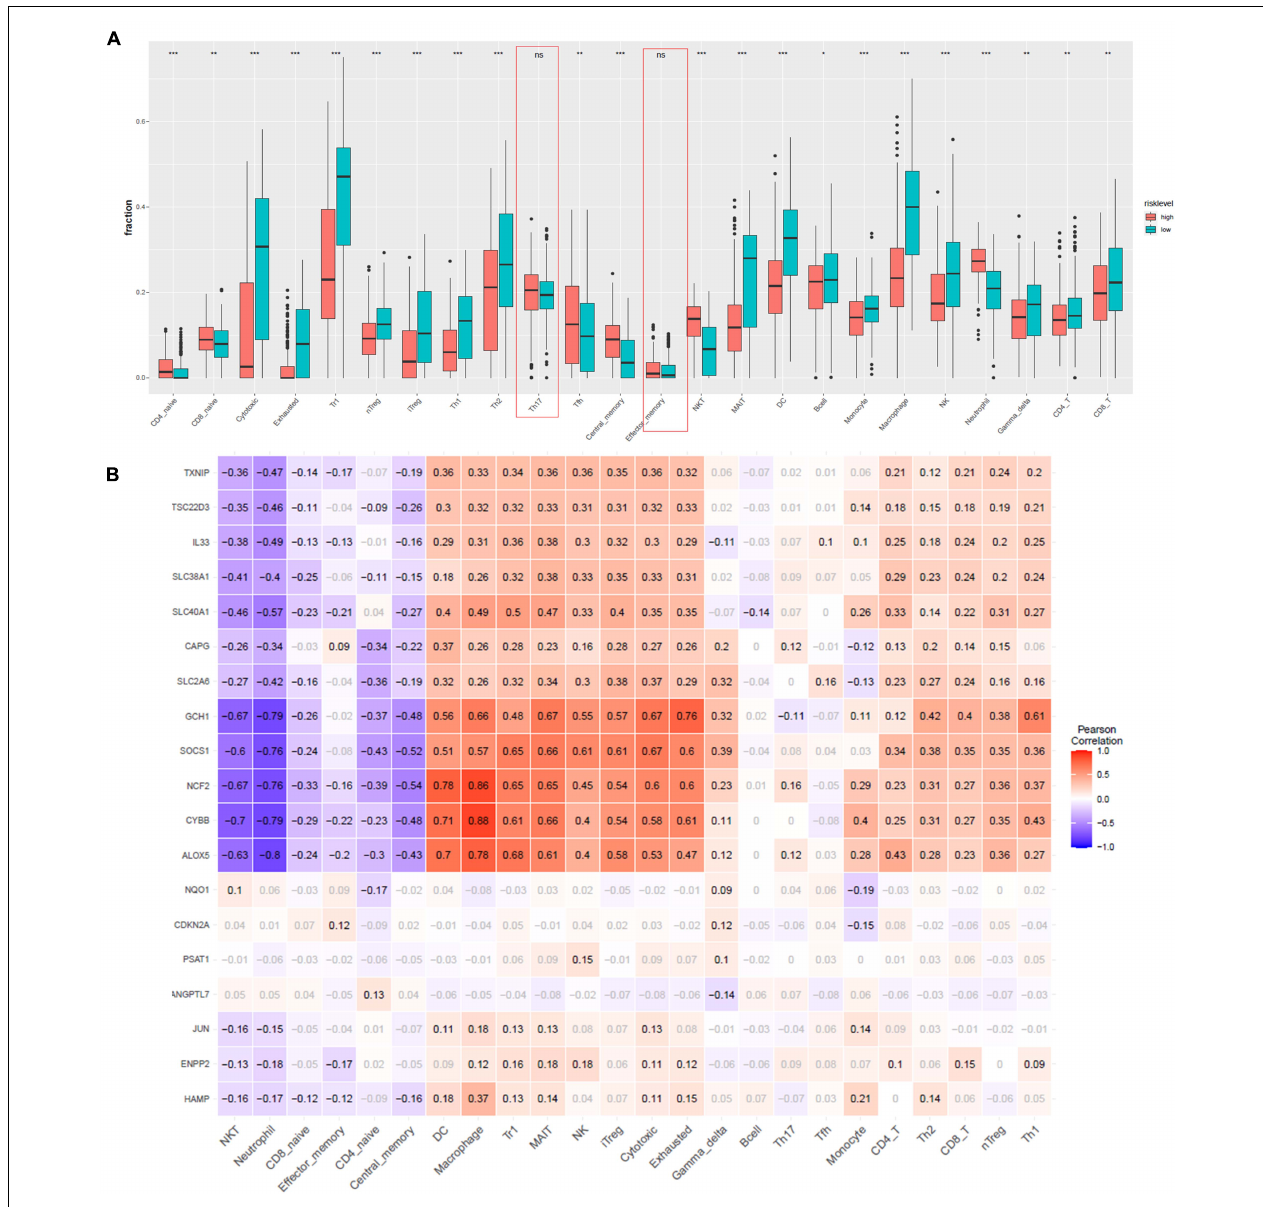
FIGURE 5 | Immune infiltration analysis. (A) Comparisons between immune cells in the high- and low-risk groups in TCGA. * p < 0.05, ** p < 0.01, *** p < 0.001, and ns designates not significant. (B) Correlation between the relative abundances of the 24 immune cells and the 19 ferroptosis-linked DEGs. The values in the squares represent the predicted Pearson correlation coefficients (–1 to 1.0), with black text indicating significant correlations (FDR < 0.05) and gray text. The colors of the squares denote the nature of the correlation, with Pearson’s correlation r = 1 for a perfect positive association, and r = –1 for a perfect negative relationship.